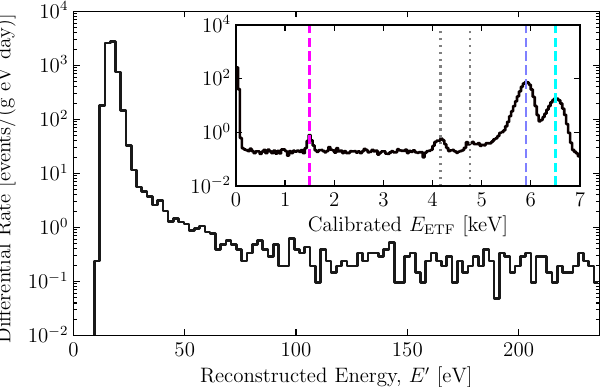
Figure 12: Measured energy spectrum in the DM-search ROI for the full exposure after application of the quality cuts. The data have been normalized to events per gram per day per eV and have been corrected for the event-selection efficiency, but not the trigger efficiency. The inset shows the calibrated E spectrum up to 7keV, ETF noting the locations of the different spectral peaks. The known values of the dashed lines are 1.5, 5.9, and 6.5keV for the Al fluorescence (pink), 55 Fe K α (blue), and 55 Fe K β (cyan) lines, respectively. The two dotted gray lines between 4 and 5keV in calibrated E are the Si escape peaks [ 56 ] . Figure and caption from Ref. [ 13 ] ETF